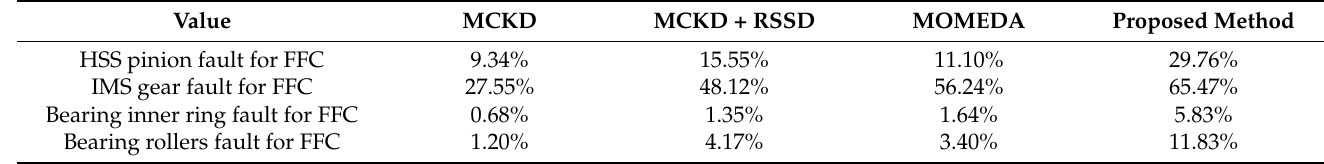
Table 4. Performance indexes of the method in this paper and the comparative methods.